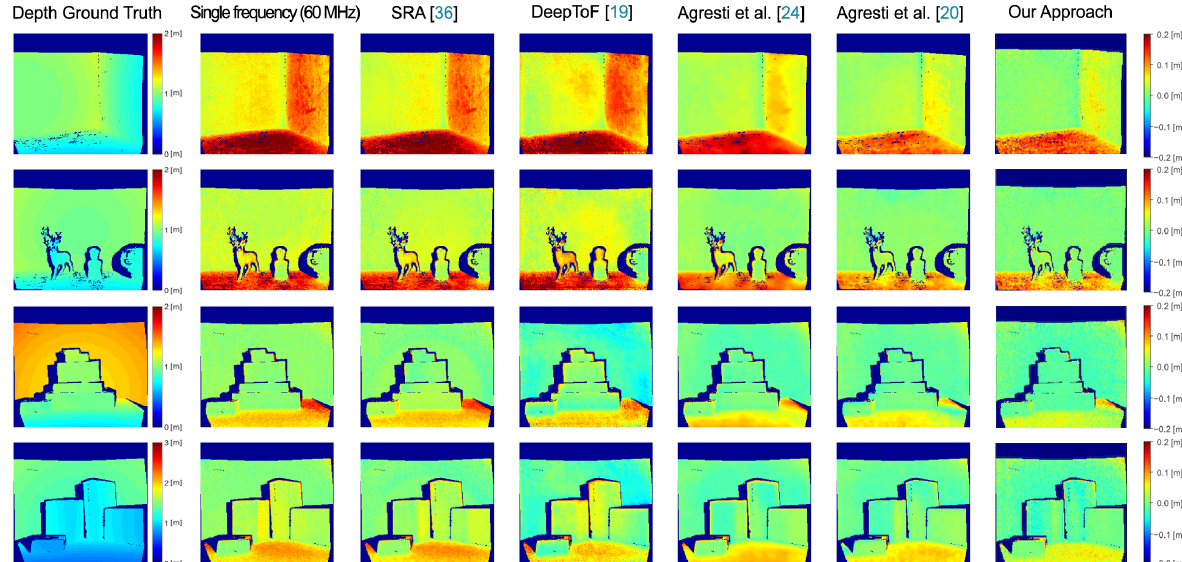
Figure 7. Qualitative comparison between several state-of-the-art MPI correction algorithms on some real scenes sampled from S 4 and S 5 . On the left side the depth ground truth is shown, while the others display the error between the prediction of each method and the ground truth.